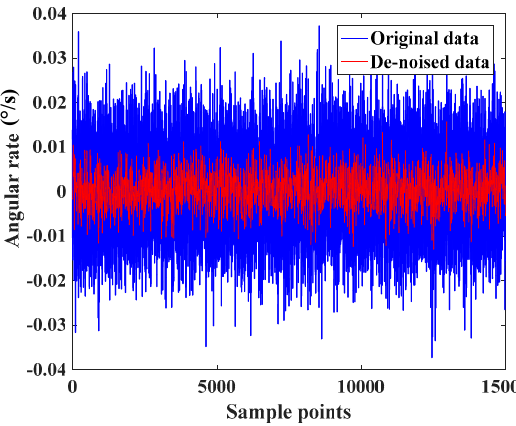
Figure 7. Original data and de-noised data of the MEMS gyroscope.